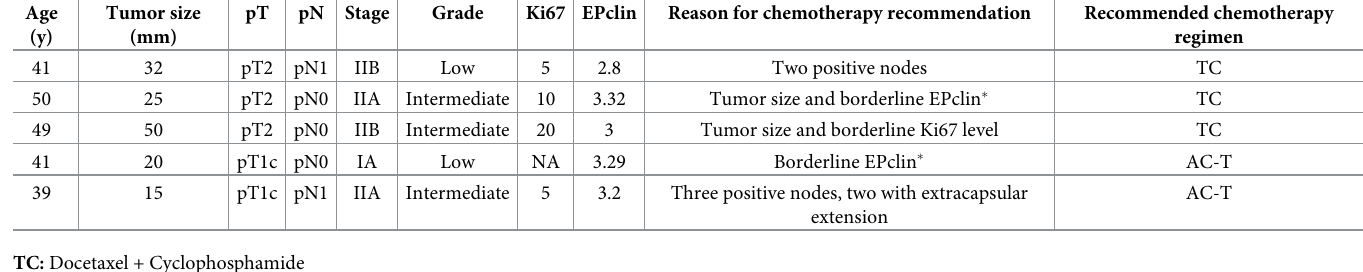
Table 4. Low-risk EPclin patients recommended to undergo chemotherapy by the tumor board.